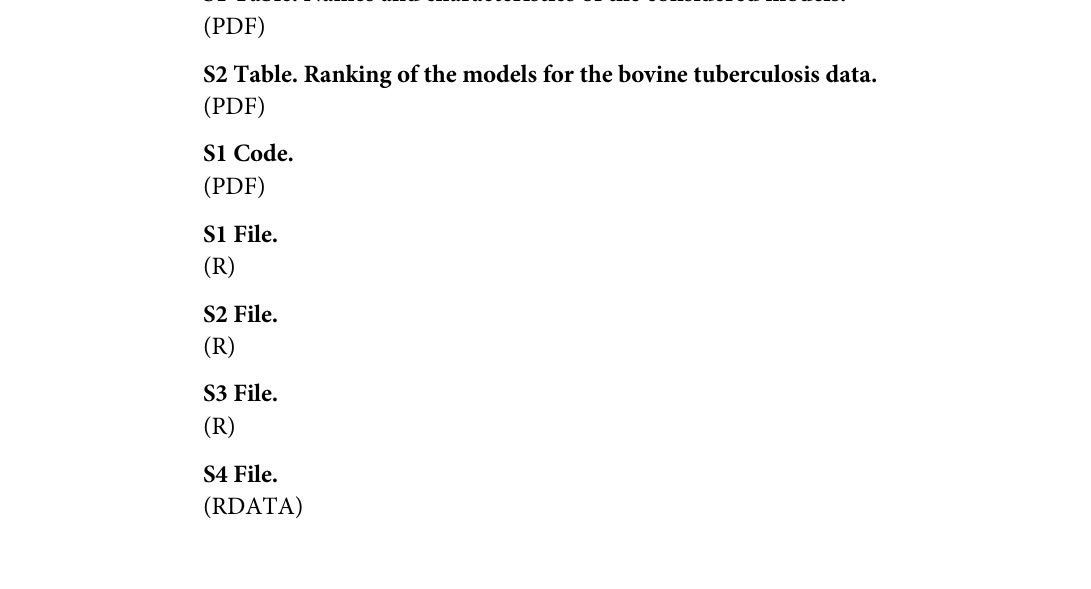
S4 Fig. Estimated risk for the bovine tuberculosis (model nebinnopar_S_T_ST_xxxx ). (TIFF) S5 Fig. Estimated risk for the bovine tuberculosis (model nebinparam_S_x_ST_xxxx ). (TIFF) S6 Fig. Estimated risk for the bovine tuberculosis (model poissnopar_S_T_ST_xxxx ). (TIFF) S7 Fig. Estimated risk for the bovine tuberculosis (model poissnopar_S_x_ST_xxxx ). (TIFF) S1 Table. Names and characteristics of the considered models. S2 Table. Ranking of the models for the bovine tuberculosis